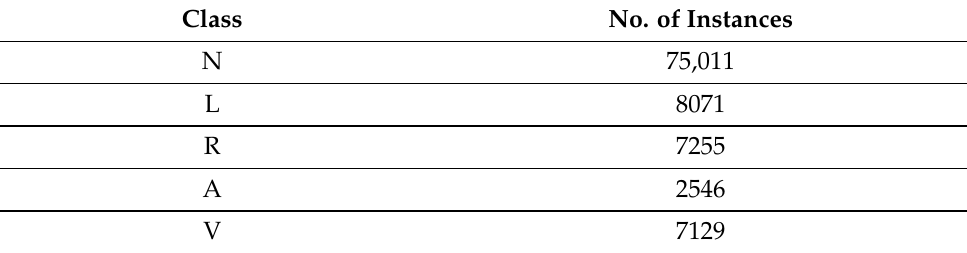
Table 8. Imbalanced Instances in